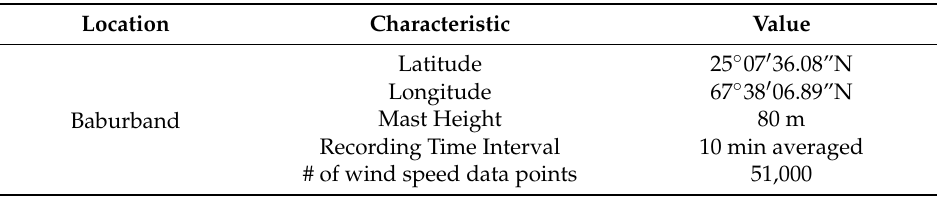
Table 1. Site and wind speed data